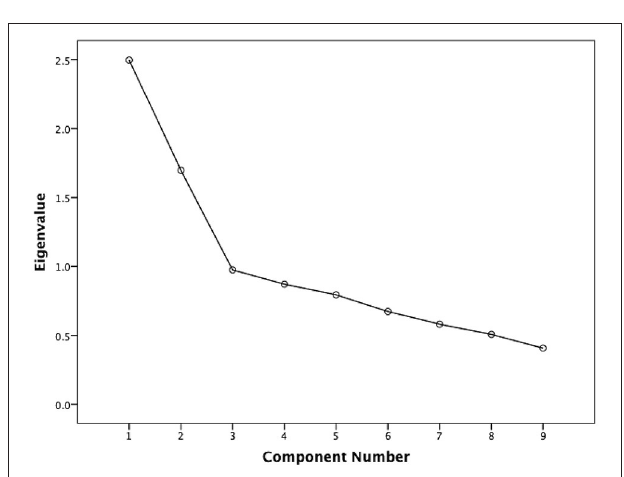
FIGURE 2 | Scatterplot between individual MADRS and QIDS-SR scores. MADRS, Montgomery–Asberg depression rating scale; QIDS-SR, quick inventory of depressive